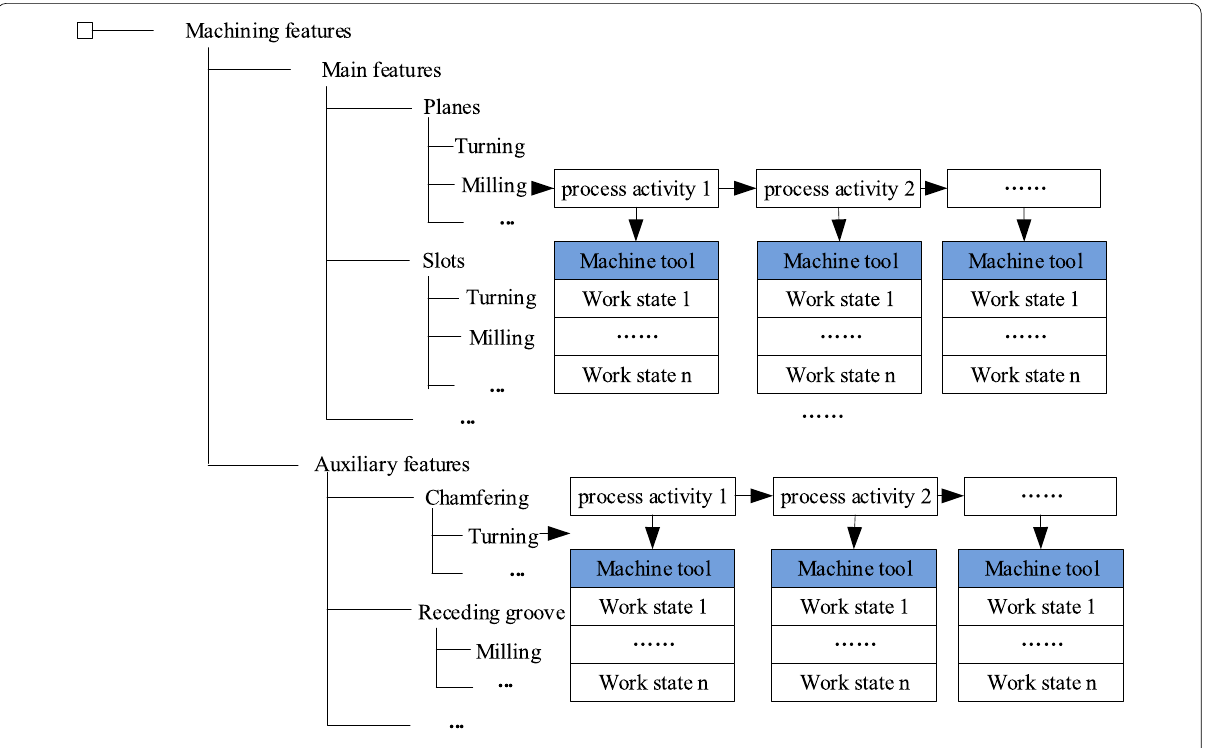
Figure 2 Relationship between machining features, process activities, and working